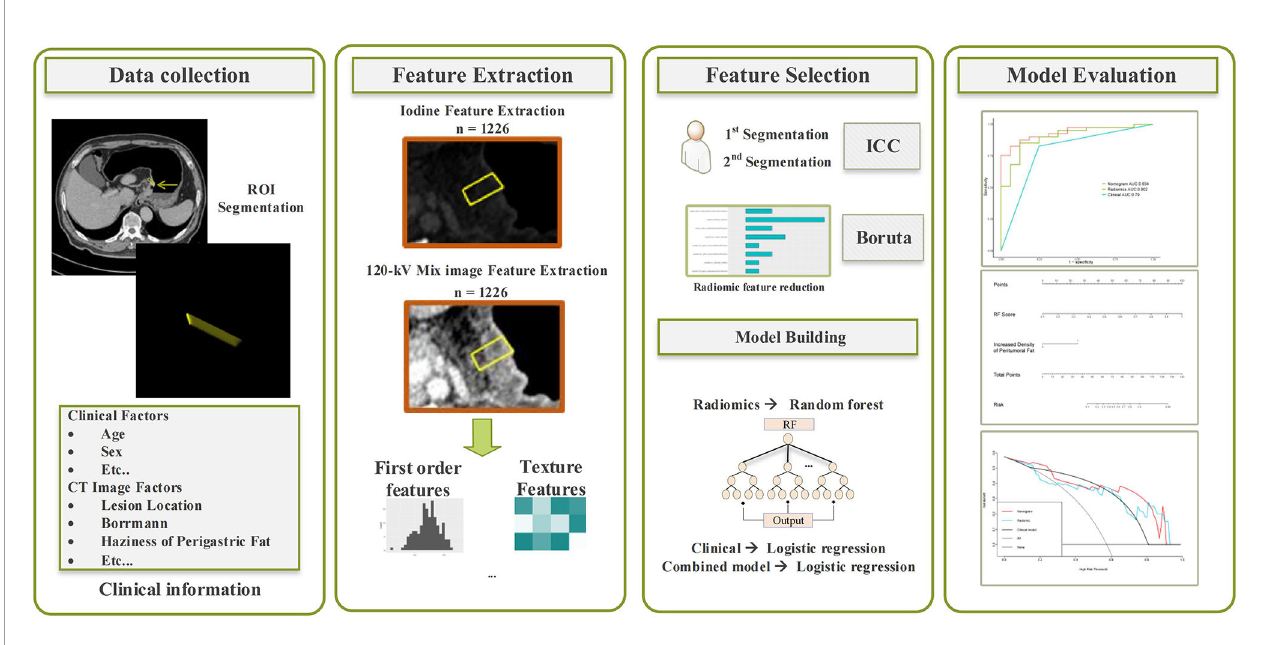
FIGURE 3 | Schematic diagram of the radiomics work fl